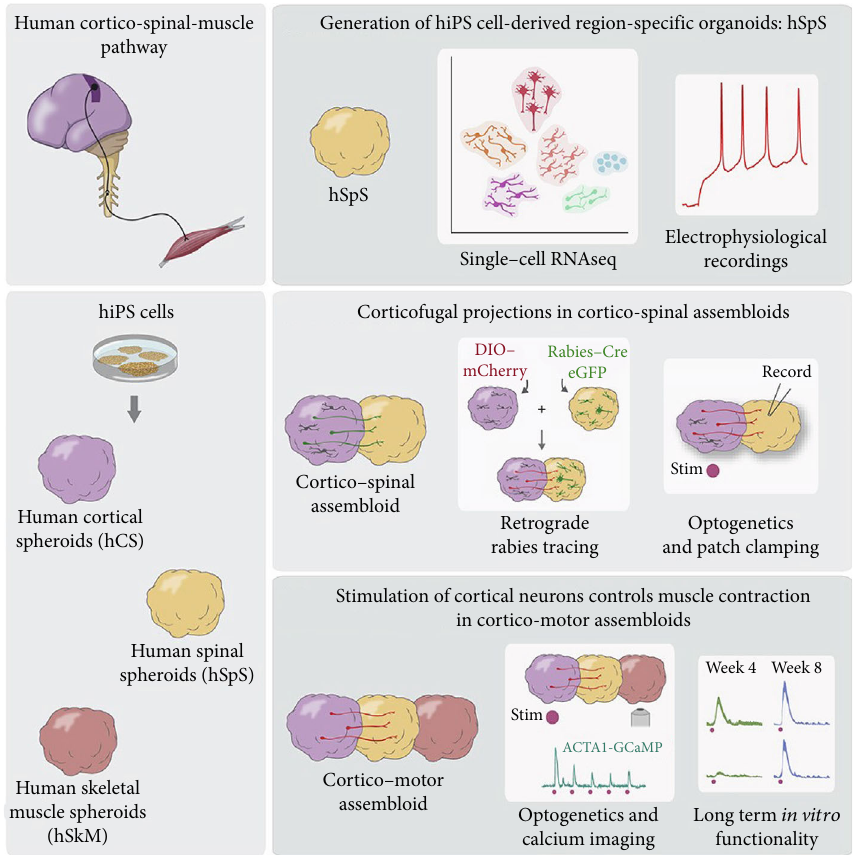
Figure 3: The assembly of 3D cultures derived from hiPS cells resembling the cerebral cortex, hindbrain/spinal cord, and skeletal muscle forms neural circuits that can be readily manipulated to model cortical control of muscle contraction in vitro. Reprinted with permission from [132], Copyright 2020